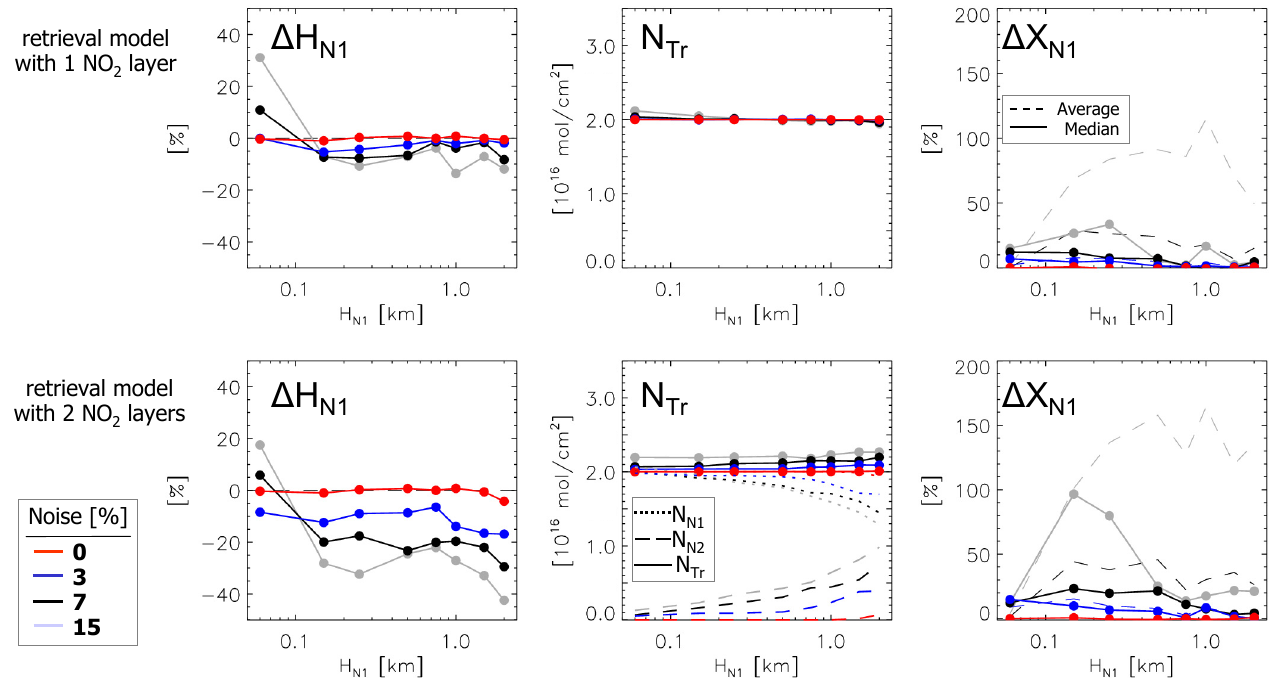
Fig. 7. Sensitivity study A. The retrieval accuracy of the NO 2 layer height, NO 2 column amounts and NO 2 volume mixing ratio for the 1 NO 2 layer model (top row) and the 2 layer model (bottom row), for different levels of Gaussian noise, as a function of the NO 2 layer height H N 1 . The black dashed lines (which are almost covered by the solid red lines) indicate prescribed values in the sensitivity study, i.e. the truth in the simulation.